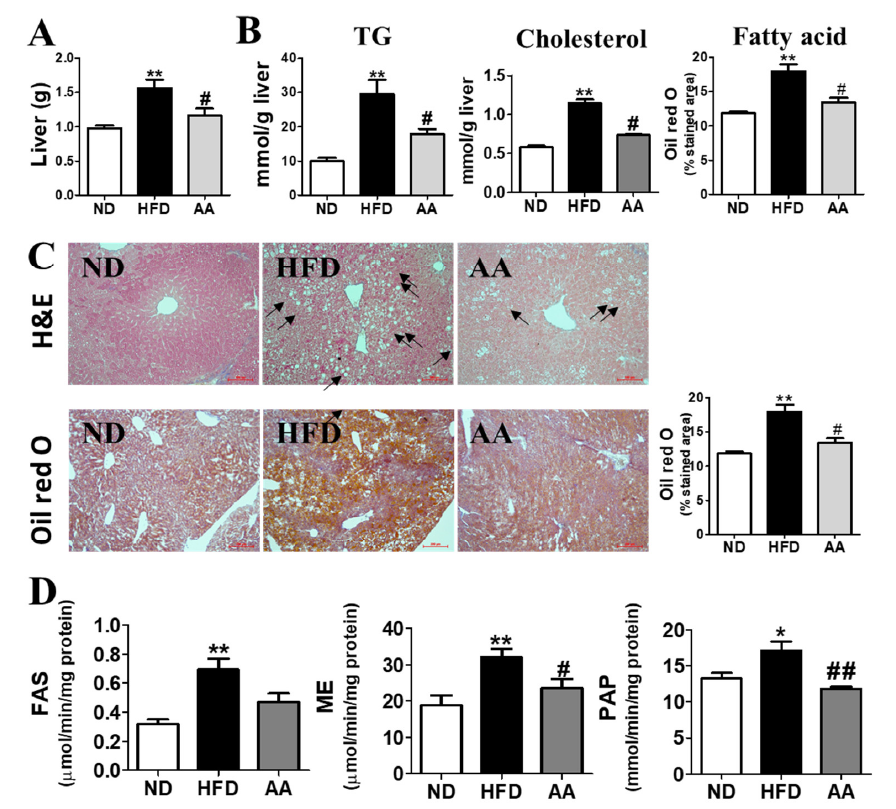
Figure 4. Effect of Artemisiae argyi water extract supplementation on diet-induced obesity. ( A ) Liver weight, ( B ) hepatic lipid content, ( C ) hepatic morphology (200× magnification), and ( D ) activities of hepatic enzymes related to fatty acid synthesis. Data are presented as the mean ± standard error of the mean. Significant differences between HFD versus ND are indicated as * p < 0.05, ** p < 0.01. Significant differences between the HFD and AA groups are indicated as # p < 0.05, ## p < 0.01. ND, normal diet (AIN-93G, n = 10); HFD, high-fat diet (60% kcal from fat, n = 10); AA, HFD + A. argyi water extract (1.5%, w/w , n = 10); H and E, hematoxylin and eosin. TG, triglyceride; FAS, fatty acid synthase; ME, malic enzyme; PAP, phosphatidic acid phosphatase. 3.5. A. argyi Water Extract Supplementation Ameliorates Oxidative Stress The hepatic antioxidant activity is shown in Figure 5A. Hepatic PON, GR, and GPx activities were significantly higher in the AA group than in the HFD group. In addition, hepatic TBARS levels were significantly lower in the AA group (Figure 5B). Furthermore, SOD activity was significantly increased and endogenous H 2 O 2 levels in the erythrocytes were significantly decreased in the AA group than in the HFD group (Figure 5C). Plasma concentration of GOT, GPT, and BUN, which are an index of hepatic function, increased in the HFD group compared to the ND group; however, the AA supplement significantly decreased compared to the values of the HFD.